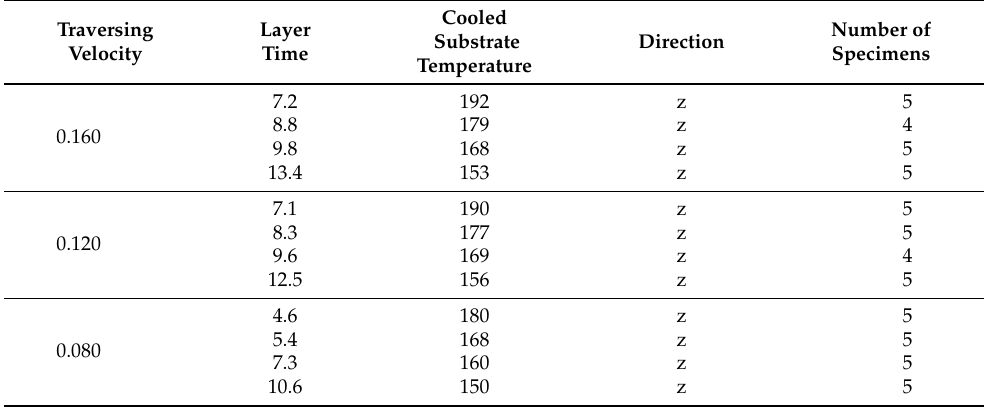
Table A3. Manufactured and tested wide cooling setups for a volumetric throughput of the pressur- ized air of 100% and a cooling distance of 50